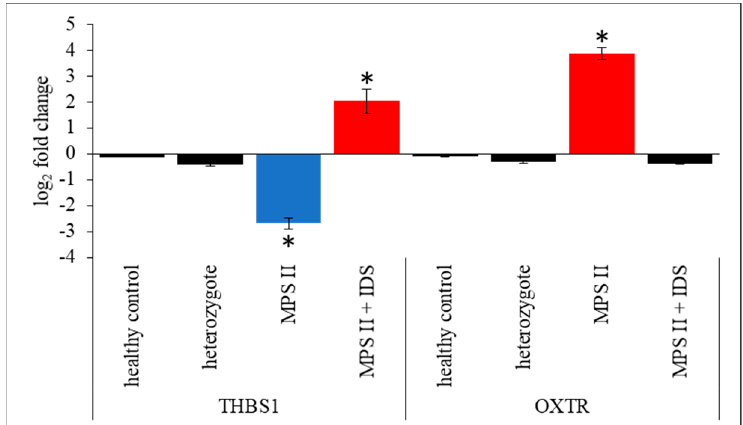
Figure 8. RT-qPCR analysis of levels of transcripts of selected genes ( THBS1 and OXTR ) in control 2 (healthy female) and control 3 ( IDUA heterozygote) fibroblasts, as well as in MPS II fibroblast, either untreated or treated with human recombinant iduronate-2-sulfatase (Elaprase, IDS) at 0.5 mg/mL for 24 h, relative to HDFa cells. Presented values are mean values from 3 experiments with SD shown as error bars. Statistically significant differences relative to control cells (HDFa) are indicated by asterisks.